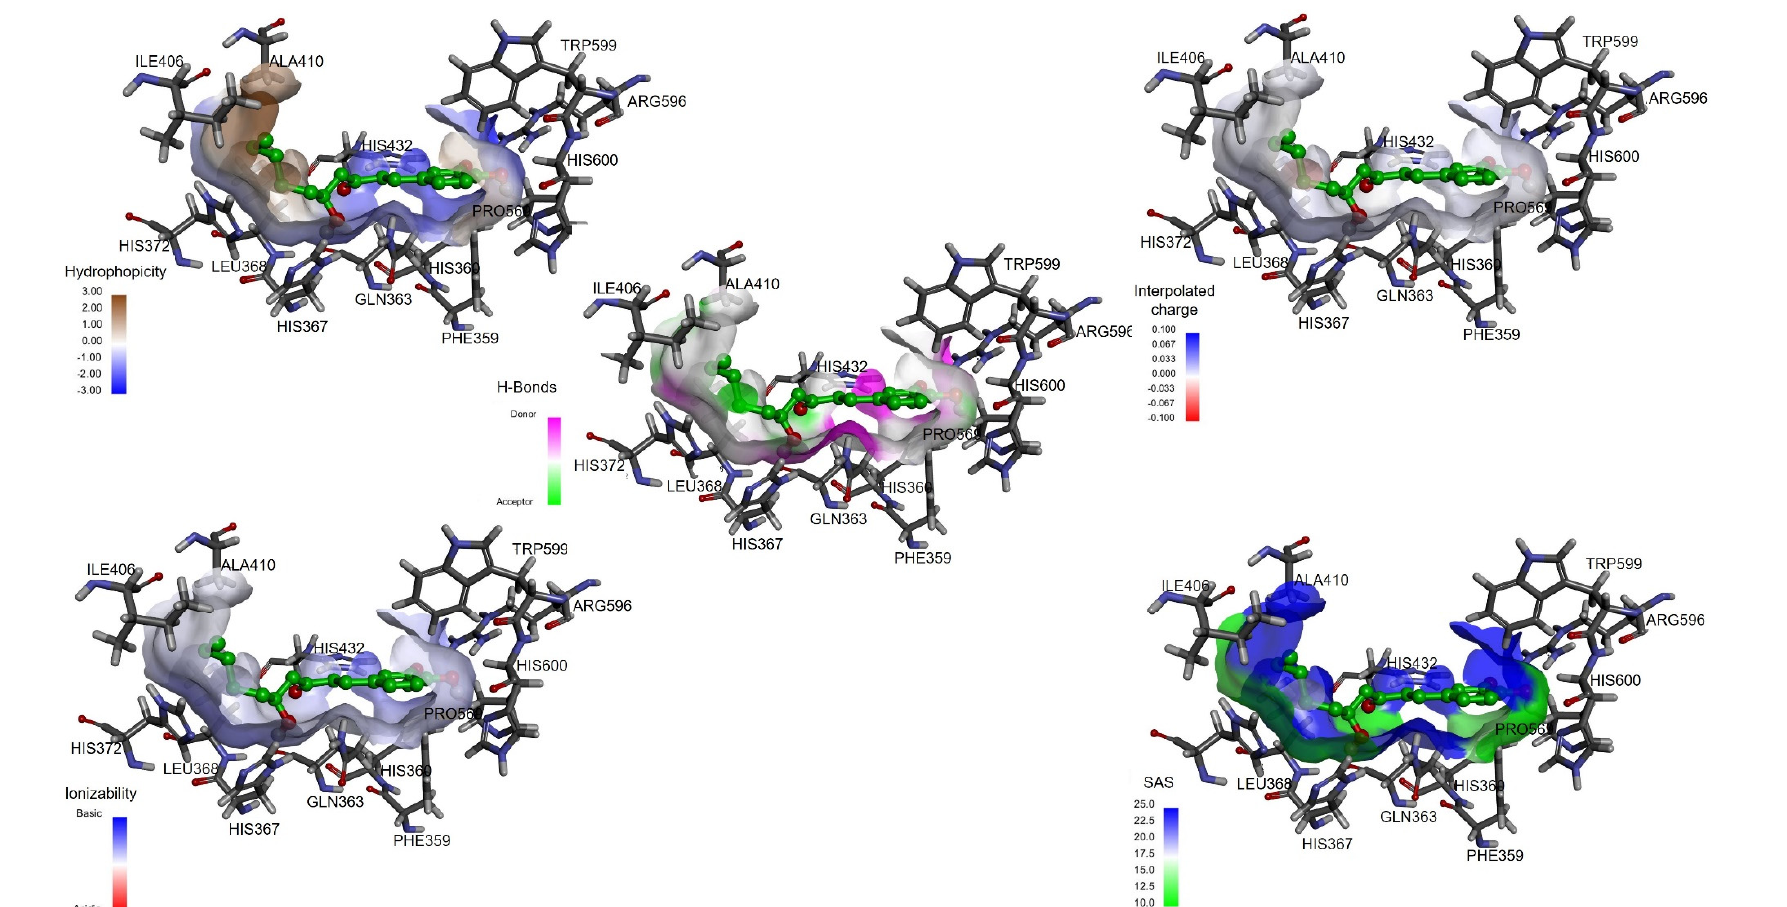
Figure 4. Interactions between the surface of 6 − shogaol and 5 − LOX (PDB:6N2W). Physicochemical complex of 6 − shogaol and 5 − LOX evaluating the hydrophobicity, hydrogen bonds, active lateral charge, ionization, and solvent-accessible surface (SASA).